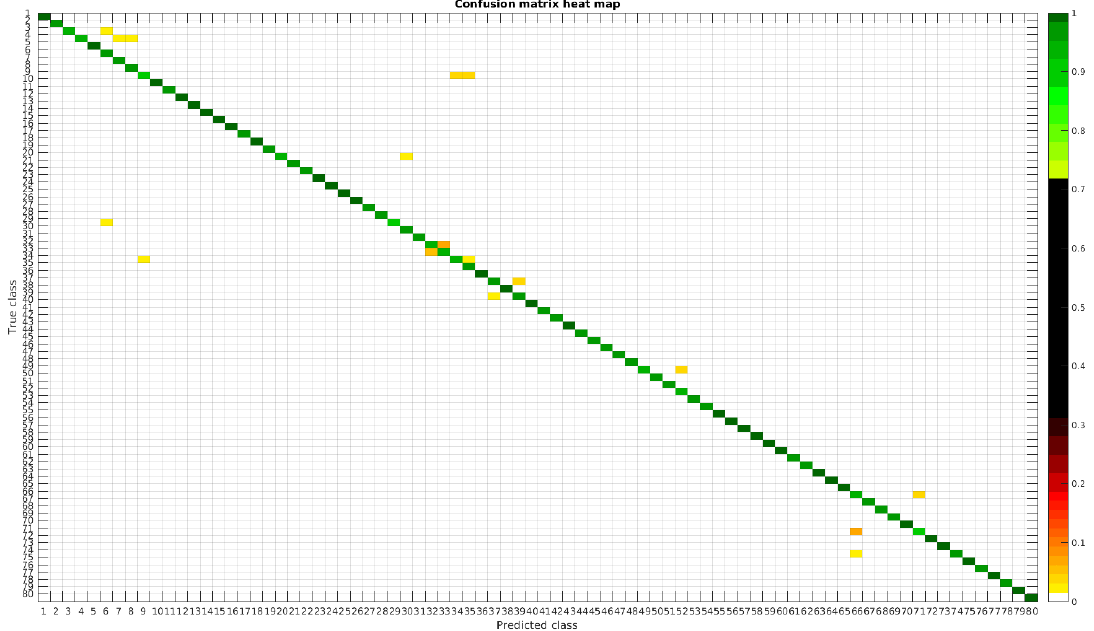
Figure 14. Confusion matrix heat map for the normalized dataset with 700 samples per